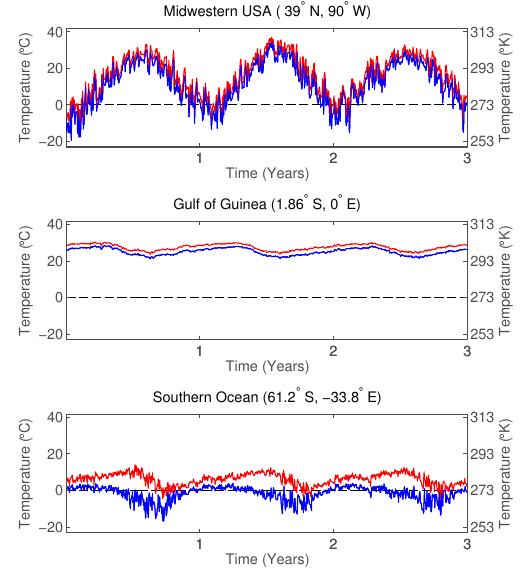
Figure 7. Time series of daily mean temperature ( ◦ C) for 3 years of reanalysis (blue) and simulations (red) at Illinois (top row), Gulf of Guinea (middle row), and Southern Ocean (bottom